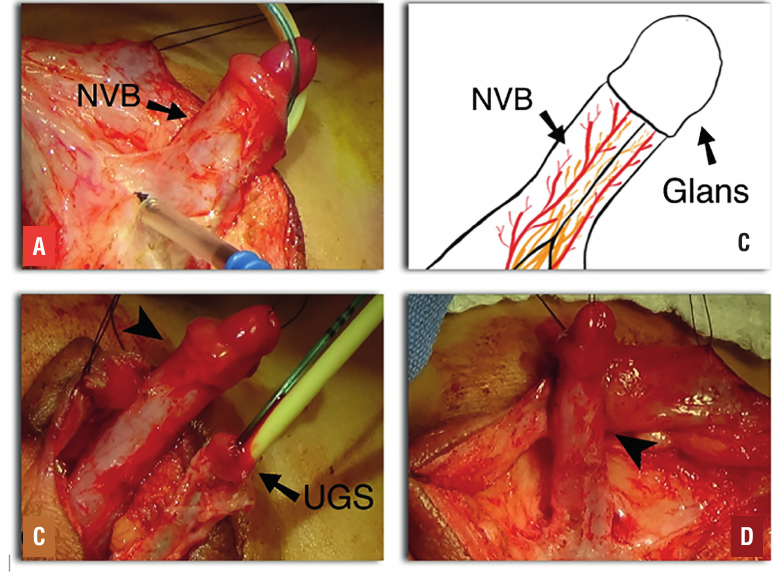
Figure 2 - Patient 1, 24 months old A) and B) Clitoral dissection preserving the dorsal neurovascular bundle (NVB) intact C. The clitoris and the NVB (Arrow head) dissected from the UGS (Arrow). D) Non-dismembered clitoris (Arrow head) with its NVB preserved.